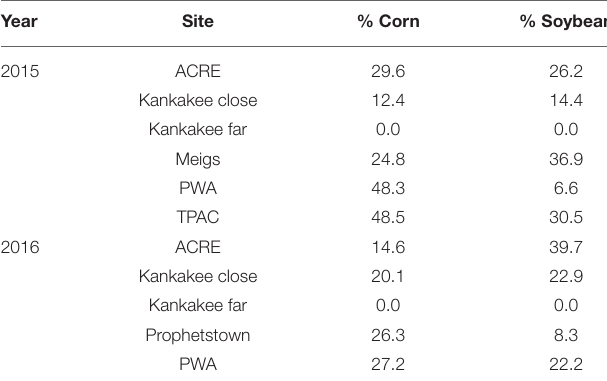
TABLE 1 | Area of corn and soybean, expressed as percent of total land use, planted in a 1km radius around milkweed sites sampled in 2015 and